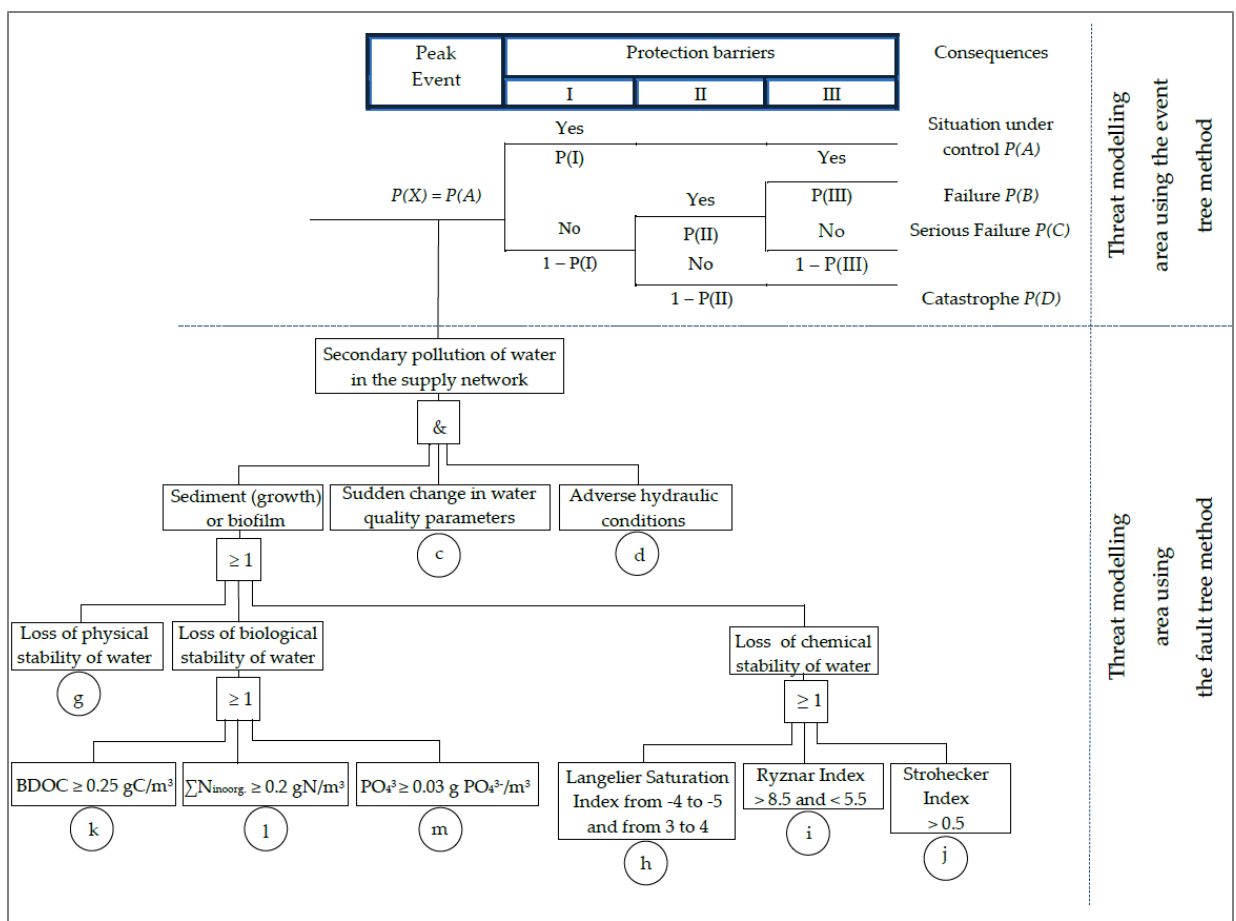
Figure 2. Hybrid Model of logical trees after a peak event related to the secondary water pollution in the water supply system. Table 1. Specific designations of the fault